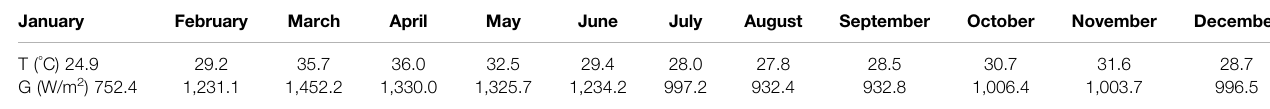
TABLE 2 | Meteorological data of the study site (Yagoua town, 2016) (Dadj é et al., 2017).